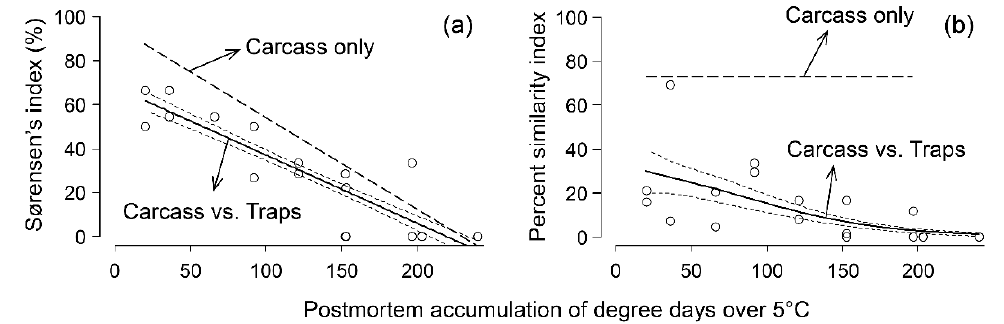
Figure 2. Comparison of Diptera documented in traps and on carcasses using the ( a ) Sorensen’s index ( r 2 = 0.78; edf = 1; F = 85.42; p < 0.01) and the ( b ) percent similarity index ( r 2 = 0.29; edf = 1.584; F = 14.72; p < 0.01) as a function of postmortem accumulated degree-days over 5 °C. The solid black line indicates the model prediction and the confidence interval of the prediction is illustrated with small dashes. For comparison purposes, the large dash line indicates the value of the index when used for carcass to carcass comparison.